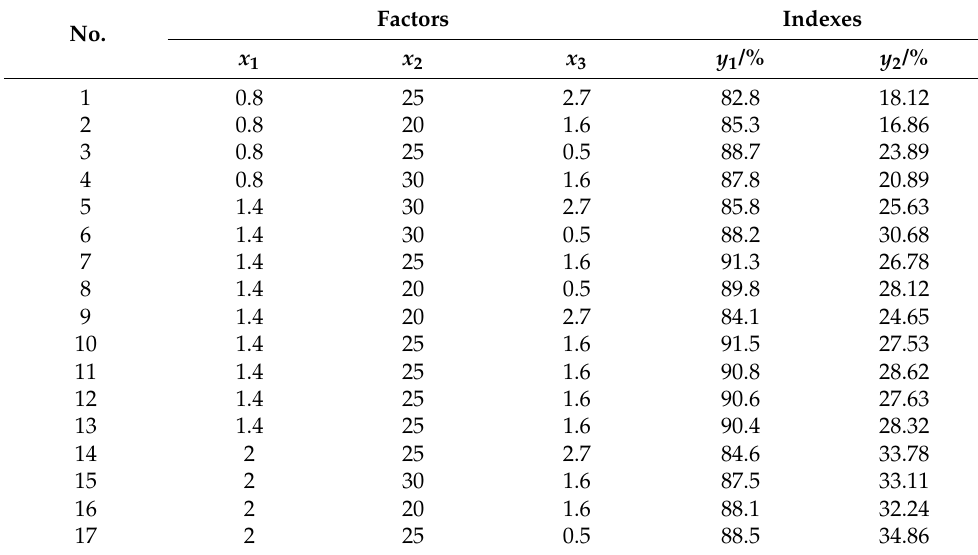
Table 2. Test scheme and